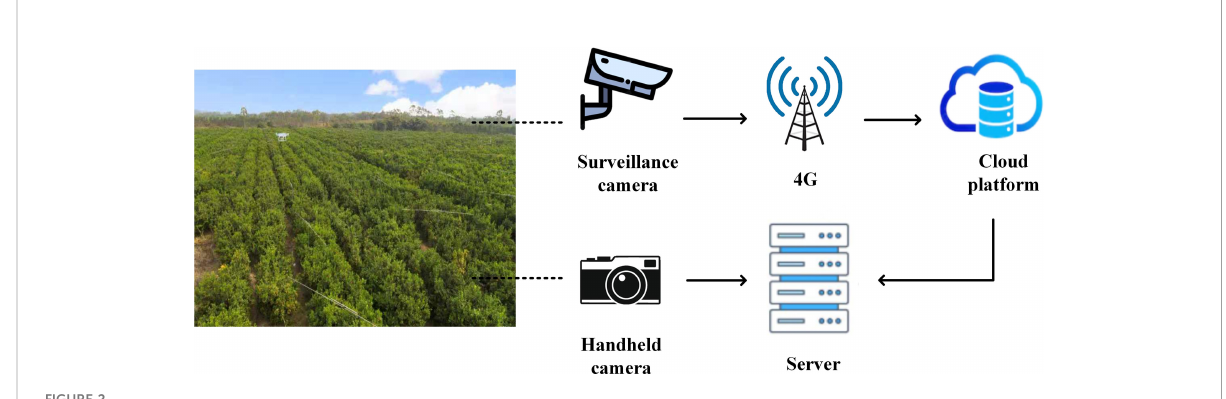
FIGURE 2 Data acquisition mode